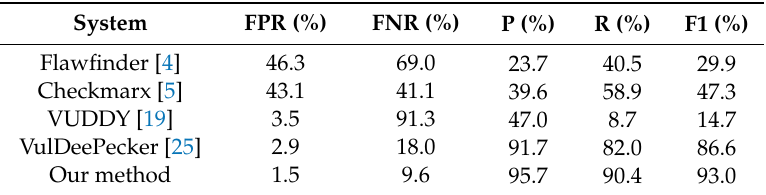
Table 8. Comparative experimental